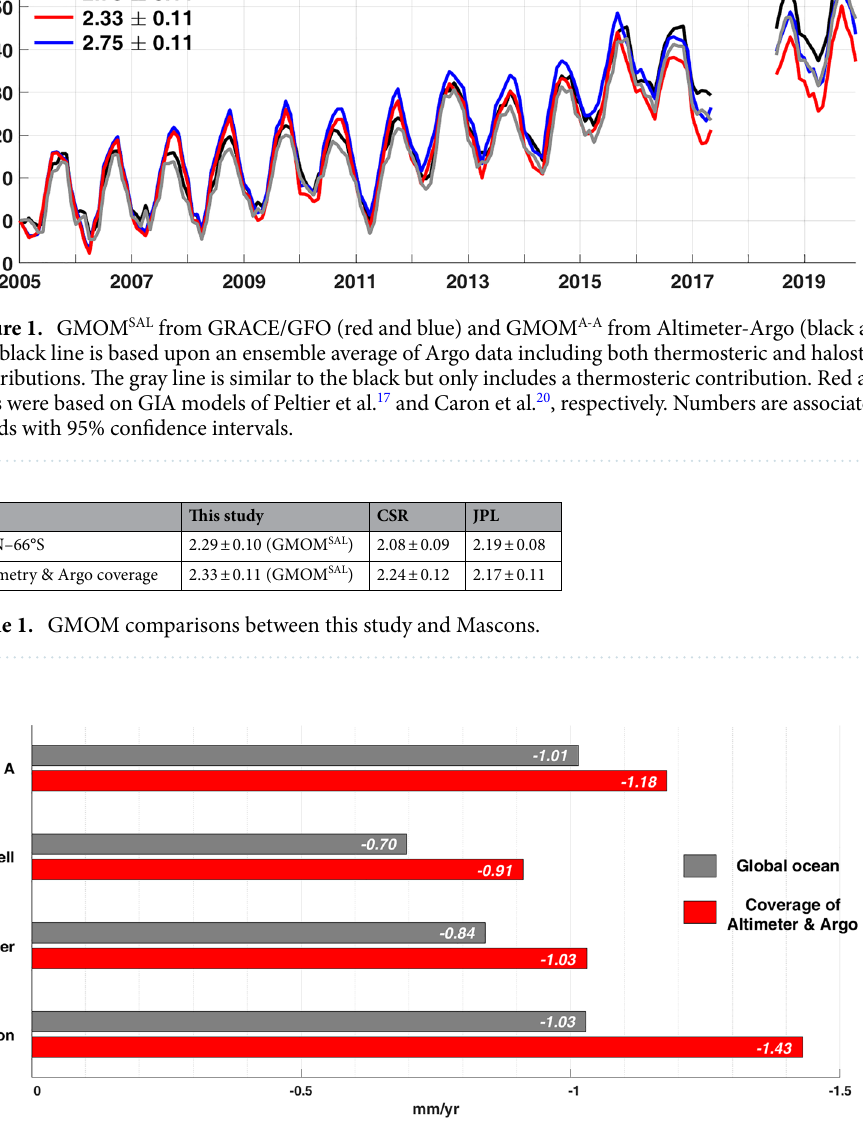
Figure 2. Apparent ocean mass rates due to GIA from GIA models of A et al. 18 ,Purcell et al. 19 ,Peltier et al. 17 , and Caron et al. 20 . Gray and red bars represent apparent water mass loads over global oceans and coverage of Altimeter and Argo,